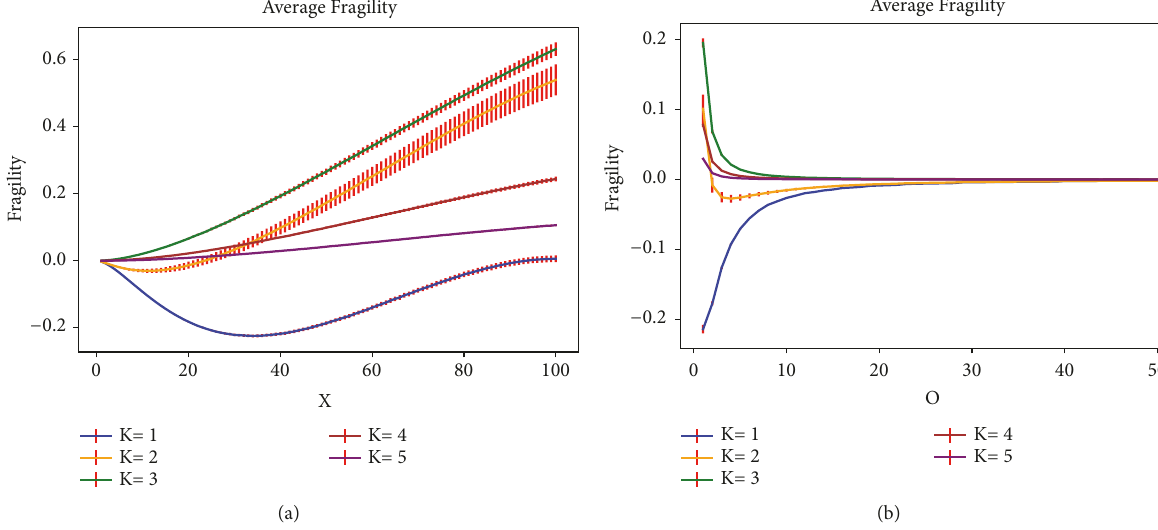
Figure 3: Average ∮ of ordered, critical, and chaotic RBNs depending on 𝑋 and 𝑂 . The error bars represent the standard error of measurements for 50 different networks at 10 different initial states ran by 200 steps. (a) 𝑁 = 100 and 𝑂 = 1. (b) 𝑁 = 100 and 𝑋 = 40.